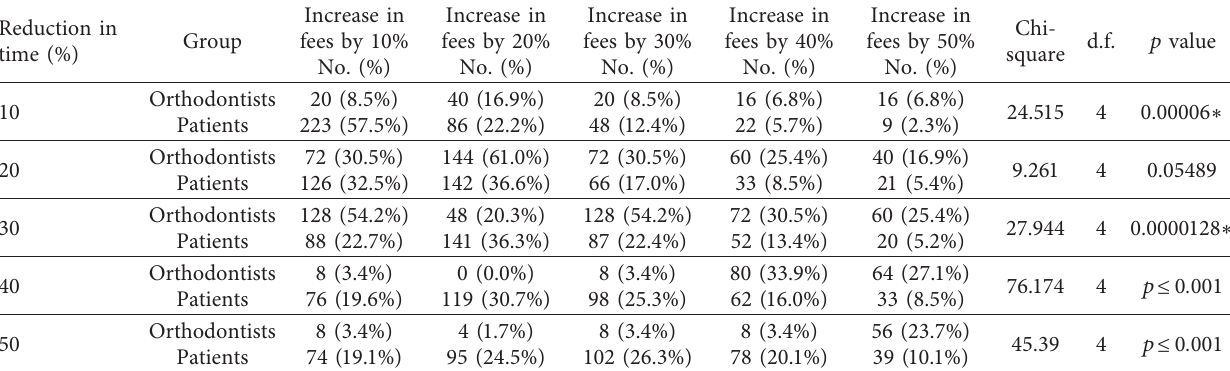
Table 5: Fee increase for reduction in